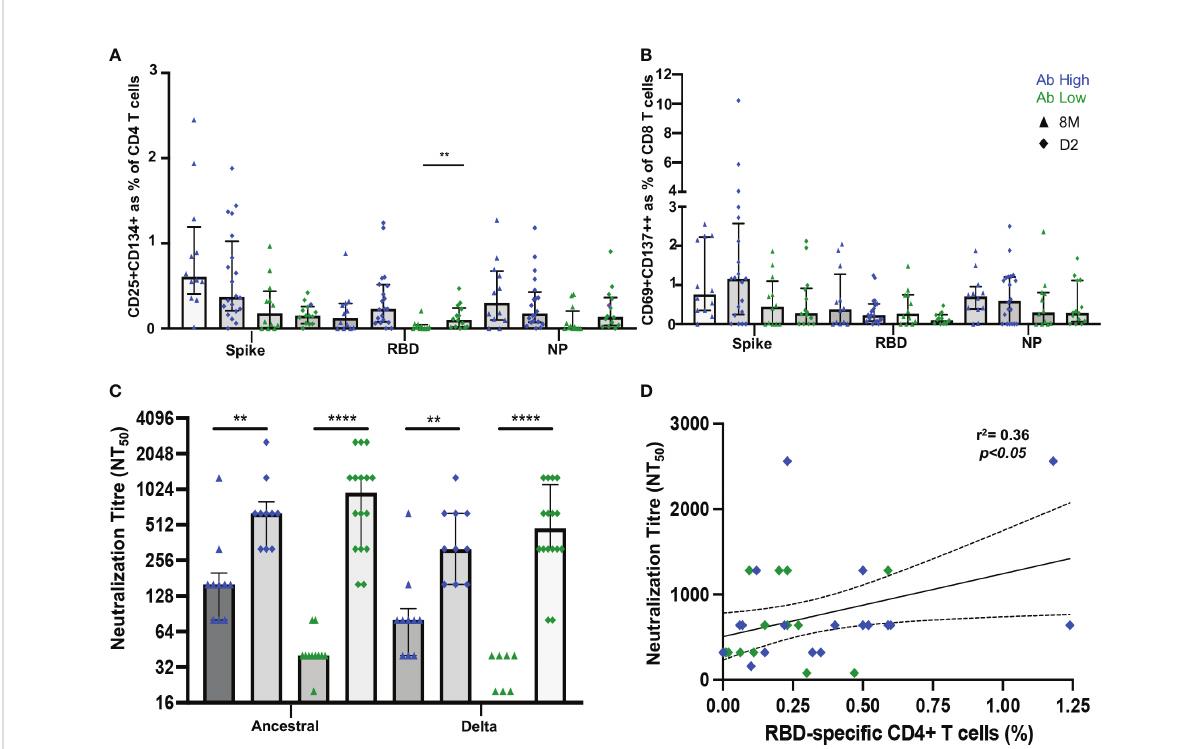
FIGURE 8 Vaccination induces RBD-speci fi c CD4 T cells in Ab low subjects. (A) Signi fi cant increase in RBD-speci fi c CD4+ T cells following vaccination in Ab low group. (B) No difference in CD8 response in both groups post-vaccination. (C) Increase in antibodies following two doses of SARS-CoV- 2 vaccination that neutralized both ancestral and delta viruses in Ab low and Ab high groups. (D) Positive correlation between RBD- speci fi c CD4+ T cells and neutralising antibody titres post second dose of vaccination. Data shown as medians with interquartile ranges. Two-tailed p values <0.05 were considered signi fi cant (** p<0.01, **** p<0.0001). Mann-Whitney T tests were used for unpaired groups. Pearson ’ s rho was used for correlations and adjusted p values